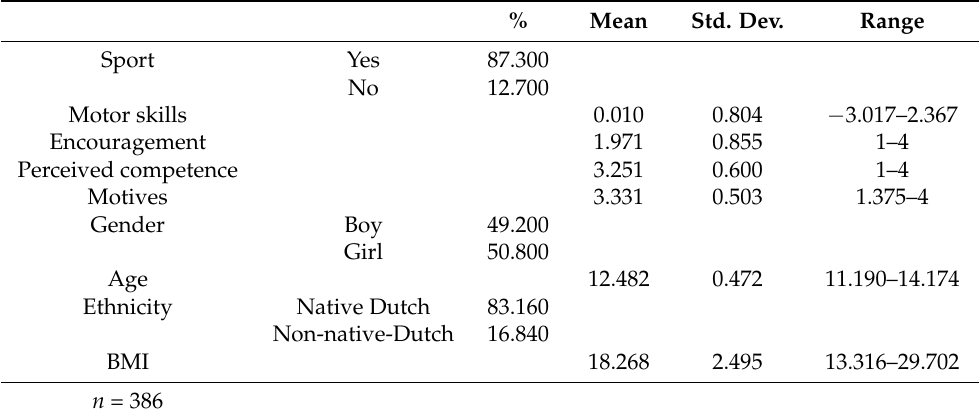
Table 1. Descriptive statistics after listwise deletion before centering to the mean. % Mean Std. Dev. Range Sport Yes